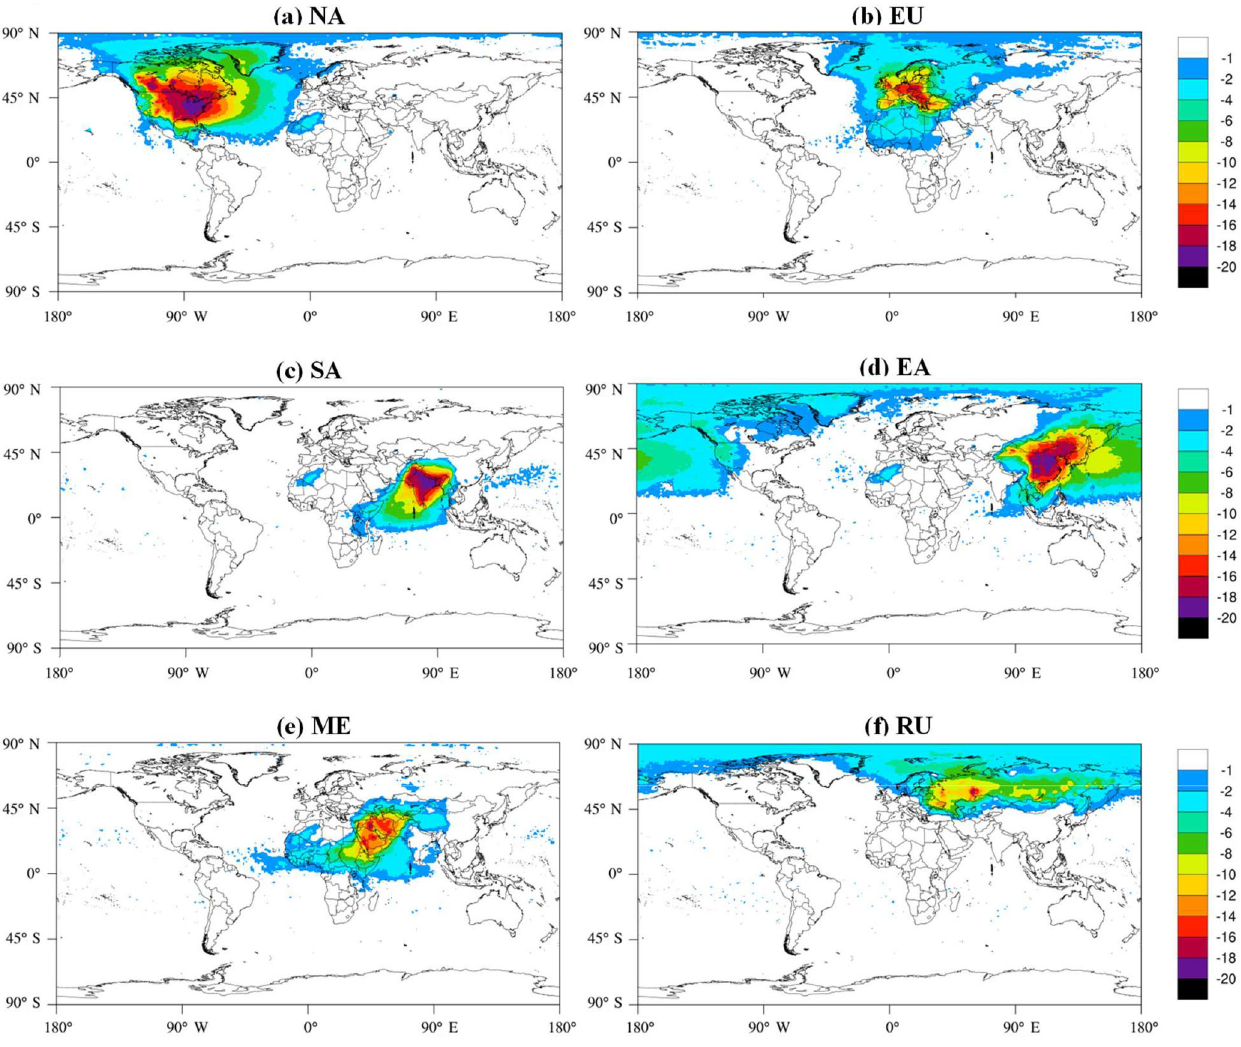
Figure 2. The response of S deposition to 20% emission reduction in the source regions. The values are the percentage changes (%) in deposition calculated as (changes in deposition with 20% emission reduction) / (base case deposition) × 100%. The unit is % per 0 . 1 ◦ × 0 . 1 ◦ grid